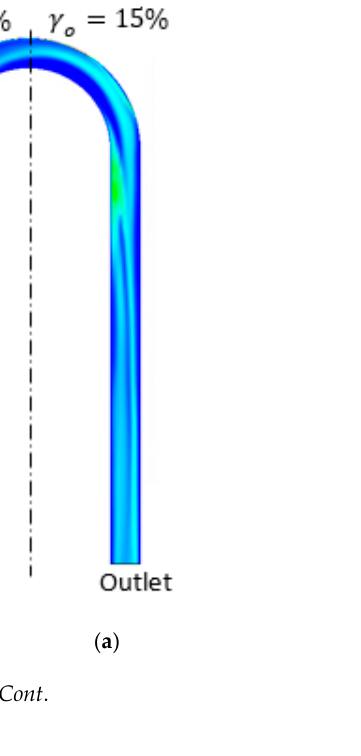
Figure 12. The gas distribution in flowmeter tube at different flow conditions obtained by numerical simulation at stratified and transitional flow regimes for CMF050. ( a ) 40.0 kg/min mixture flow rate, 15% GVF at the inlet, 3% gas asymmetry (𝛾 (cid:3031) ) , CMF050. ( b ) 40.0 kg/min mixture flow rate, 10% GVF